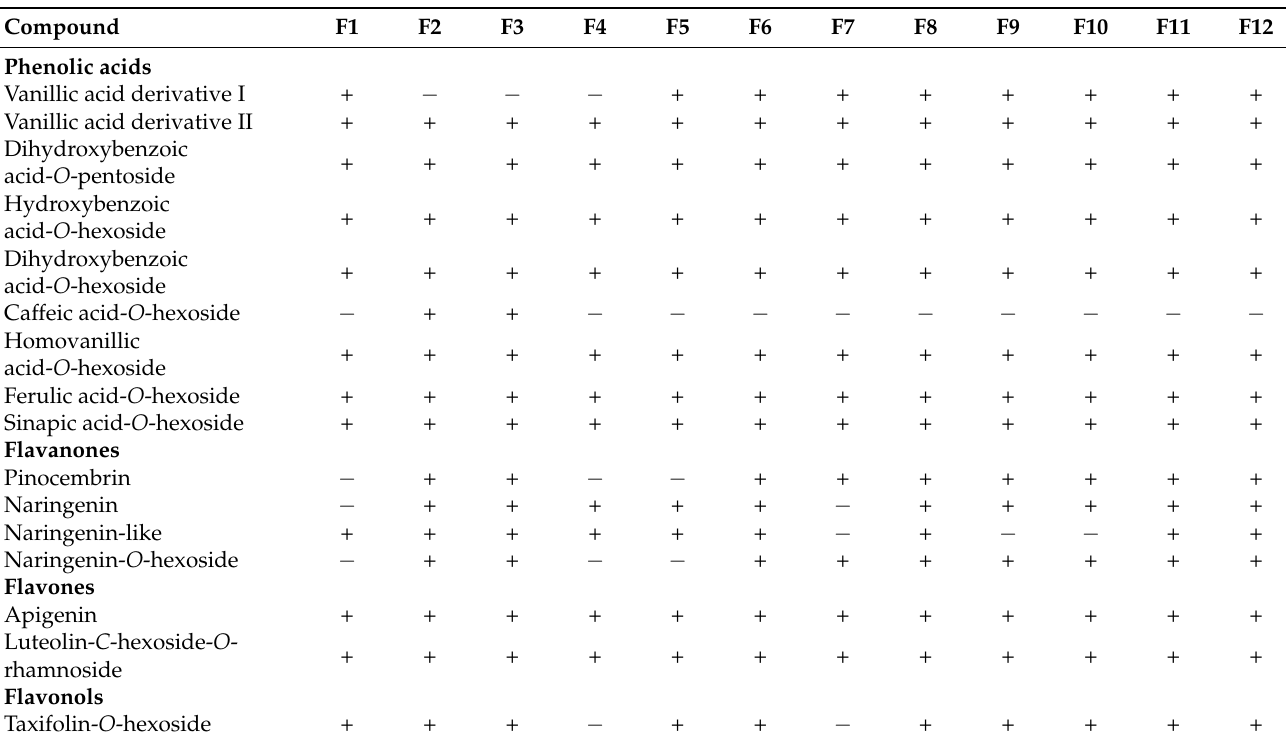
Table 2. Occurrence of minor (poly)phenols in fig